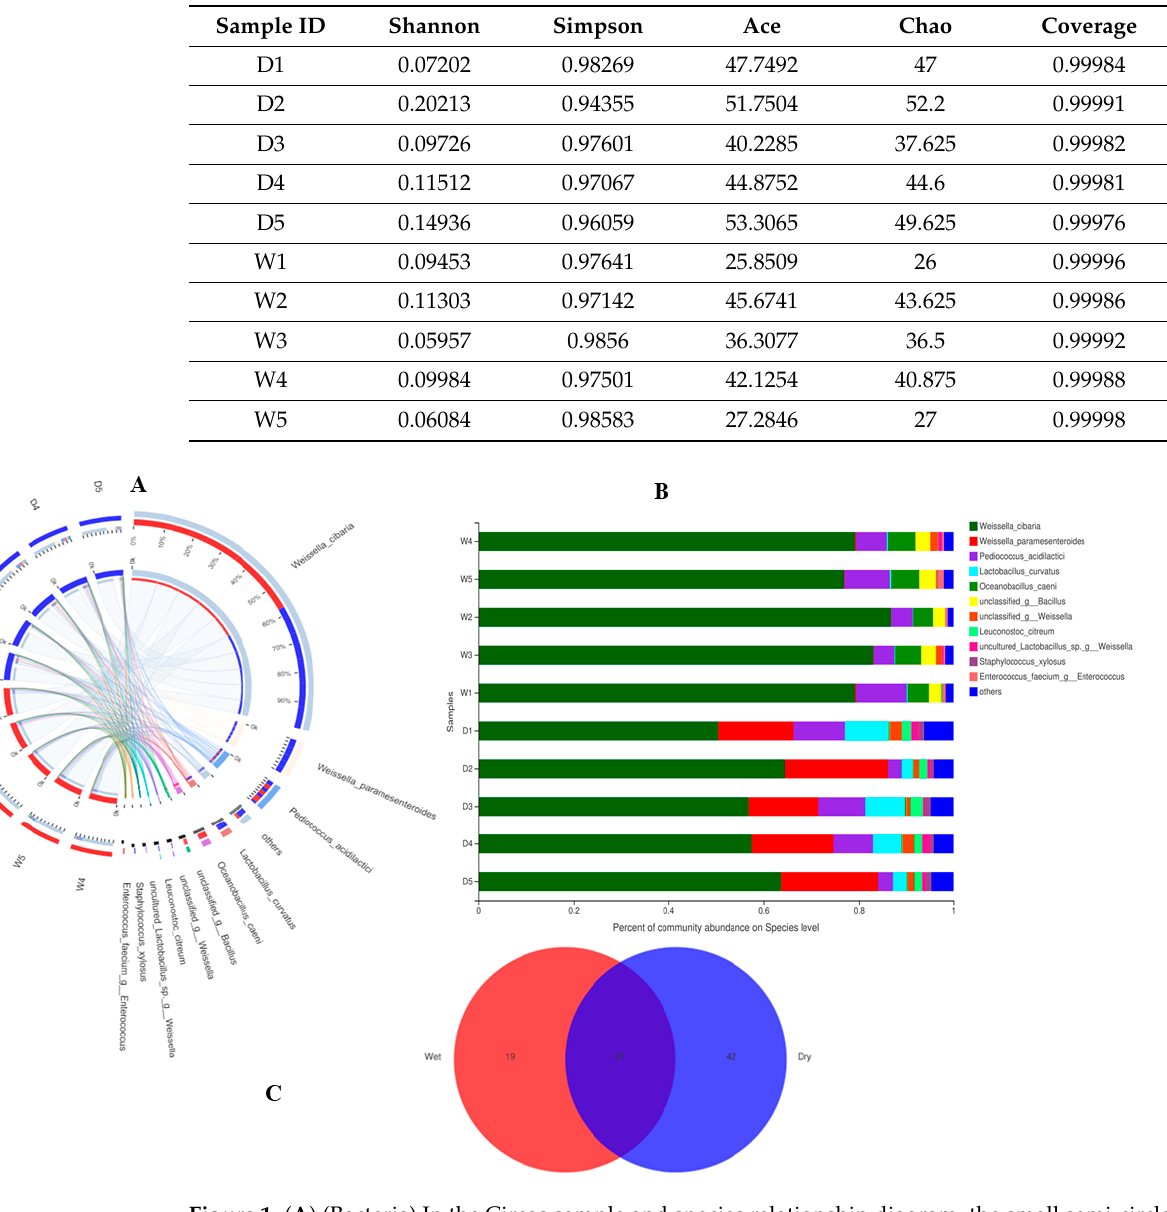
Figure 1. ( A ) ( Bacteria) In the Circos sample and species relationship diagram, the small semi-circle (left half circle) represents the composition of species in the sample, the color of the outer ribbon represents which group it comes from, the color of the inner ribbon represents the species, and the length represents the species’ relative abundance in the corresponding sample; the large semicircle (right half circle) represents the distribution ratio of species in different samples at the taxonomic level, the outer ribbon represents species, the inner ribbon color represents different groups, and